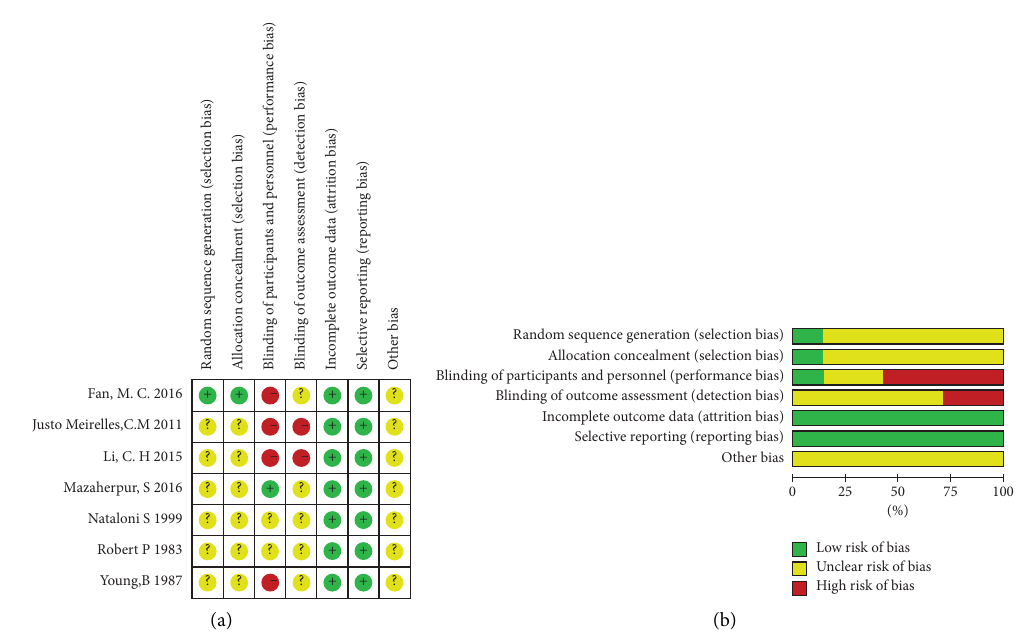
Random sequence generation (selection bias) Allocation concealment (selection bias) Blinding of participants and personnel (performance bias) Blinding of outcome assessment (detection bias) Incomplete outcome data (attrition bias) Selective reporting (reporting bias)